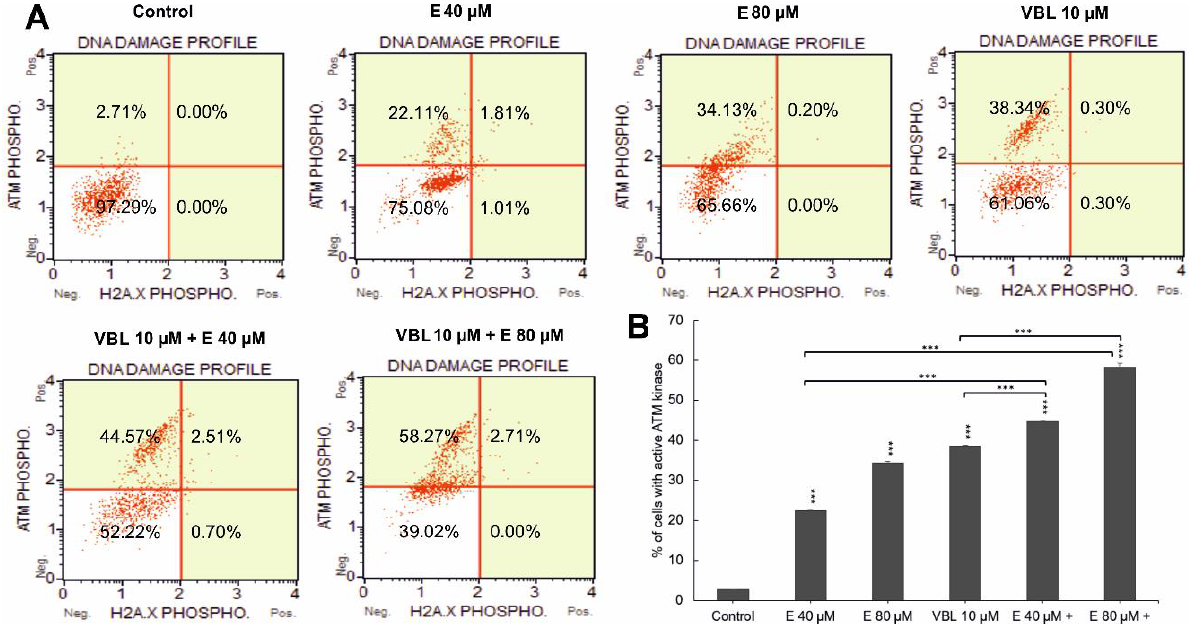
Figure 5. Degree of DNA damage induced by emodin and vinblastine. ( A ) HeLa cells treated for 24 h with emodin (40 and 80 µM), vinblastine (10 µM), and emodin and vinblastine (E 40 and 80 µM + 10 µM VBL) to induce DNA damage. Cells were stained with anti-phospho-histone H2A.X (Ser139) and anti-phospho-ATM (Ser1981) antibodies. ( B ) Percentage of cells with active ATM kinase. Data representative of three parallel experiments correspond to mean ± standard error (S.E.) values. Differences were statistically confirmed at: *** p < 0.001.